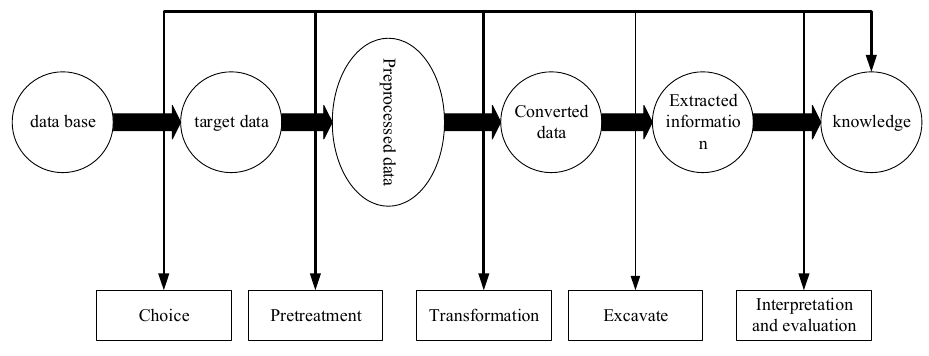
Figure 3. Data-mining process steps.